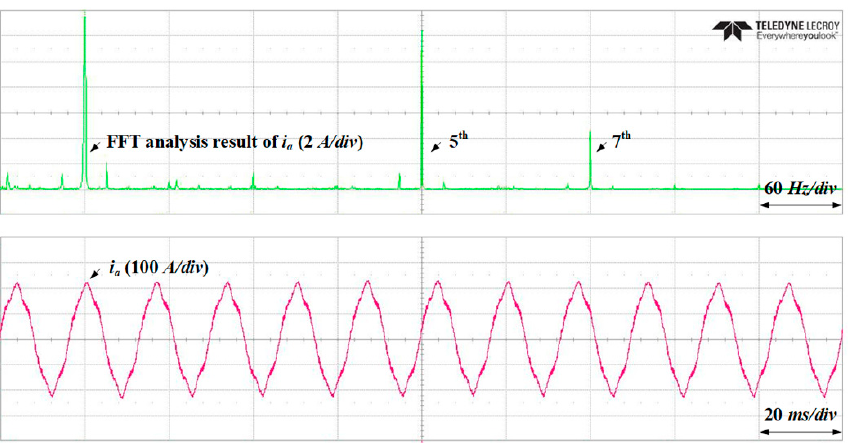
Figure 21. Experimental results when no harmonic compensation method is applied.